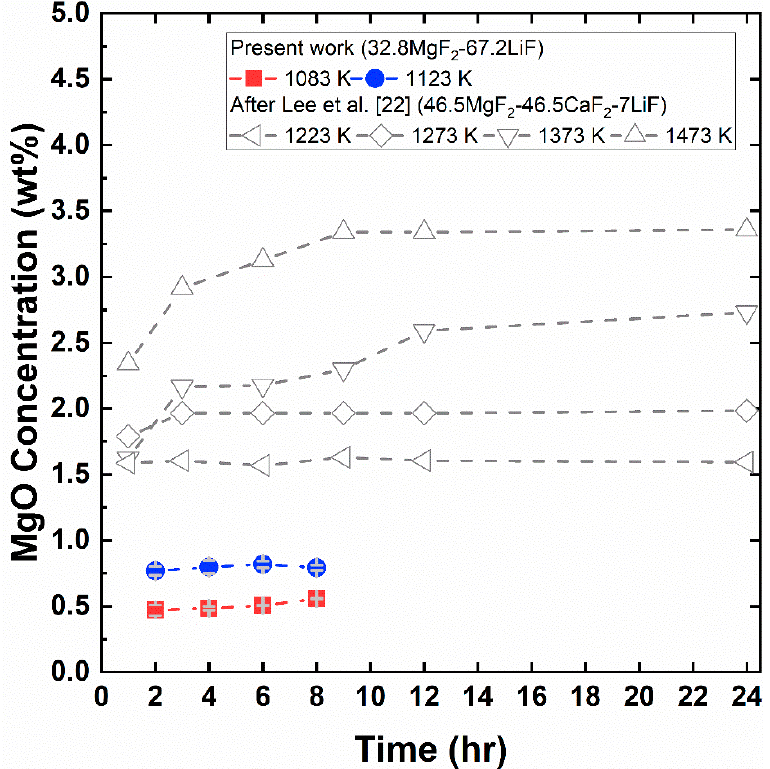
Figure 3. The solubility of MgO in the 32.8MgF2–67.2LiF and MgF 2 –CaF 2 –LiF [22] systems with varied reaction times.